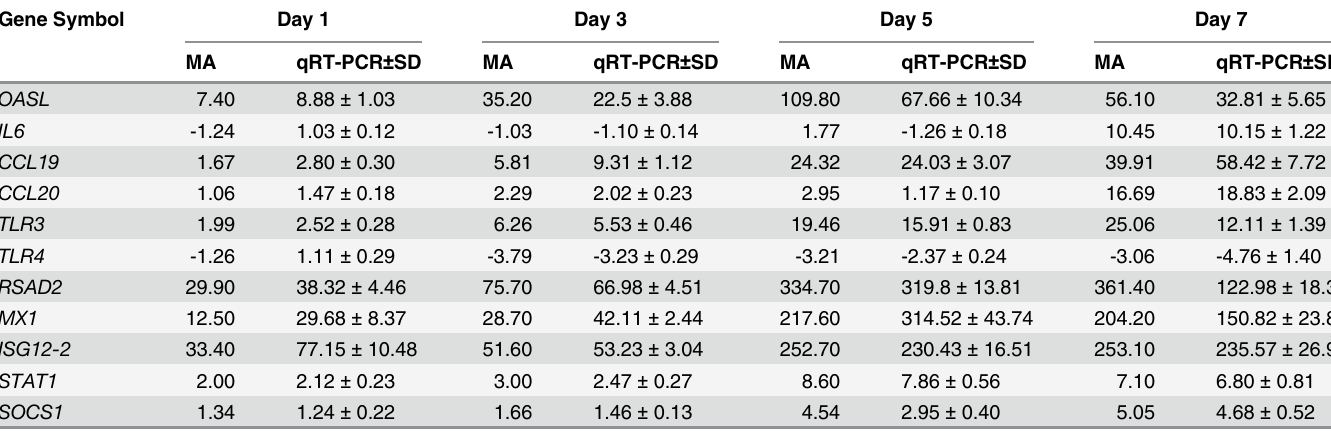
Table 5. Comparison of fold changes obtained using microarray and qRT-PCR analysis.